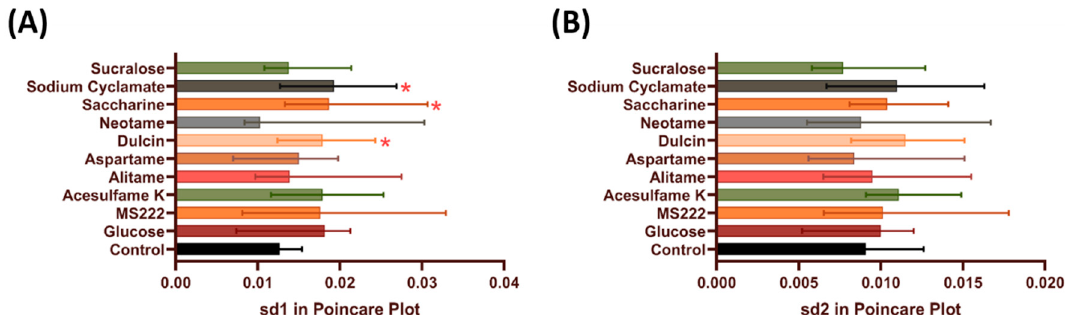
Figure 3. Comparison of heart rate variability in zebrafish larvae after acute incubation of eight different artificial sweeteners at highest environmental relevant concentration (100 ppb). Data analysis was based on the standard deviation 1 ( A ) and standard deviation 2 ( B ) generated by Poincare Plot and presented as median with interquartile range. Statistical significances were tested by Kruskal–Wallis test followed by uncorrected Dunn’s test as post-hoc multiple comparison test ( n = 15). Red asterisk shows significant increase compared to control (* p < 0.05).